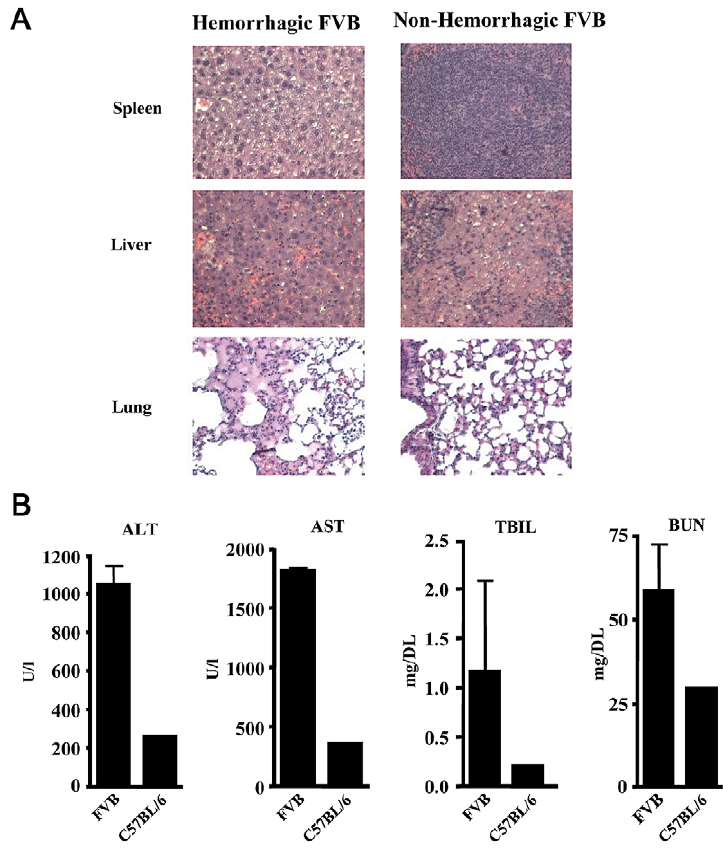
Figure 5. Indications of tissues damage in FVB mice following LCMV infection. FVB or C57BL/6 mice were infected with 1–2 6 10 6 p.f.u. LCMV-13 and blood or tissue samples were taken at day 7 post-infection. A) Histological comparison of infected diseased and normal tissue in FVB mice. Signs of splenic, hepatic and pulmonary necrosis in FVB diseased mice in upper, middle and lower panels, respectively. B) Clinical chemistry profiles of alanine aminotransferase (ALT), aspartate aminotransferase (AST), total bilirubin (TBIL) and blood urea nitrogen (BUN) are shown. LCMV infected C57BL/6 data are presented as the values from combined serum collected from 4–5 mice. LCMV infected FVB data is presented as the mean + / 2 standard deviation of two groups of 3–5 mice. Results are representative of three independent experiments.